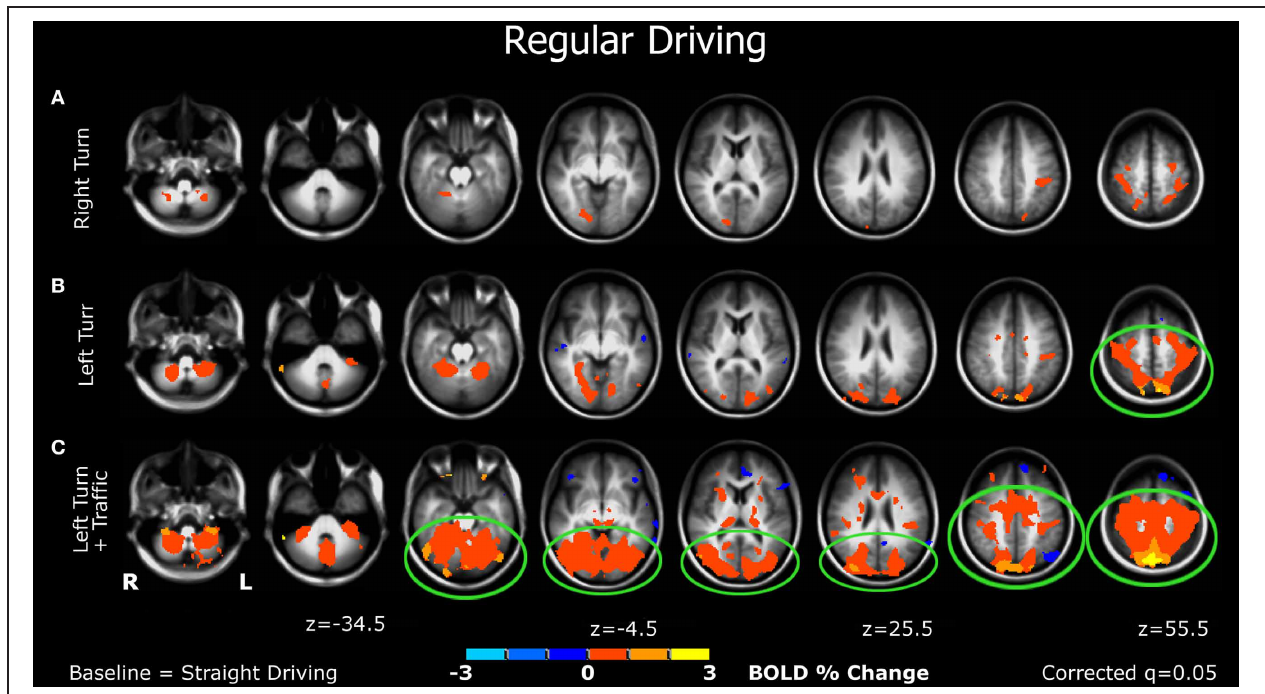
FIGURE 3 | Brain activations from the bottom to the top of the brain (left to right figures) of participants when performing various simulated driving conditions. (A) The right-turn condition showed minimal activation in the brain; (B) Left-turn showed